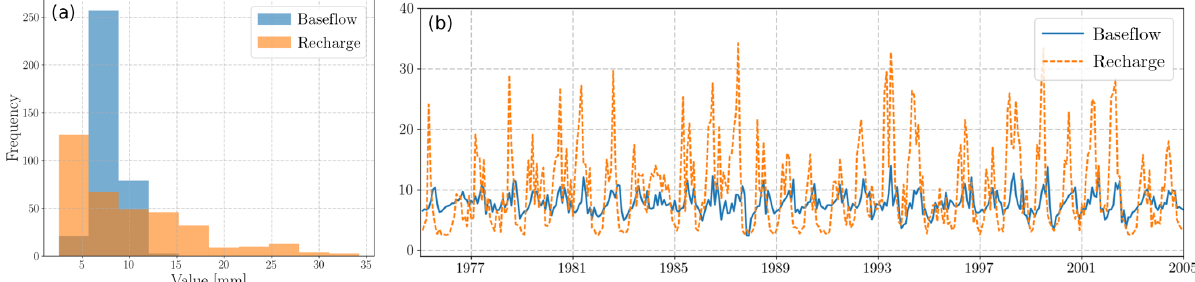
Figure 9. Analysis of groundwater inflow (recharge) and outflow (baseflow) over the Nägelstedt catchment. (a) Distribution of groundwater balance components. (b) Monthly time series of groundwater recharge and